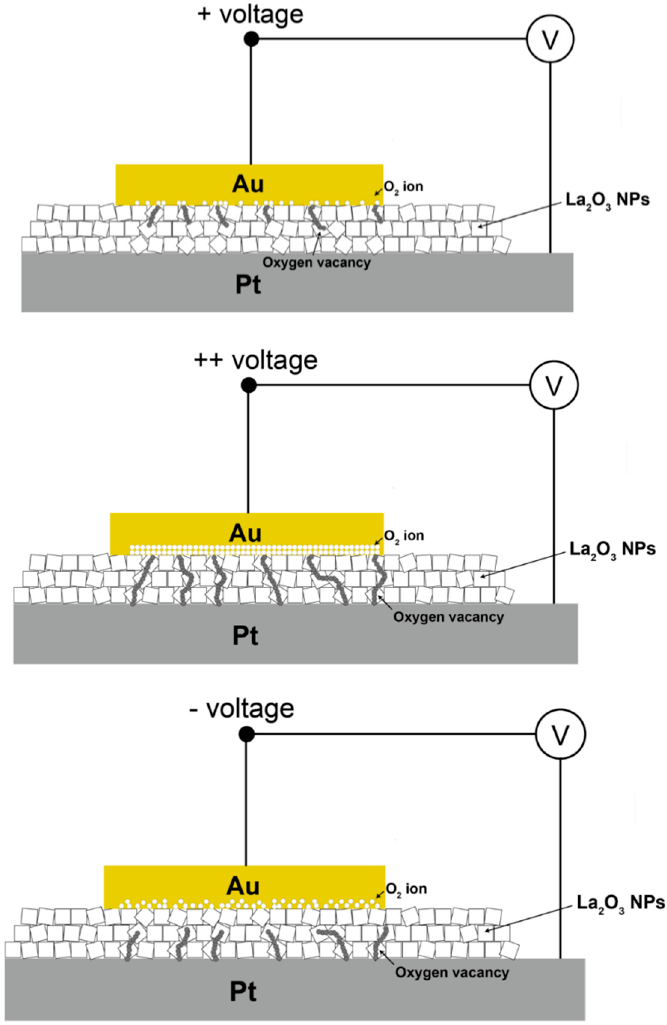
Figure 6. Schematic illustration of conduction filament formation in the mixed LaO x NPs layer facilitated by bridged segments; initiation of filaments during the first SET; SET transition through filament formation at positive voltages, and RESET transition at negative voltages.